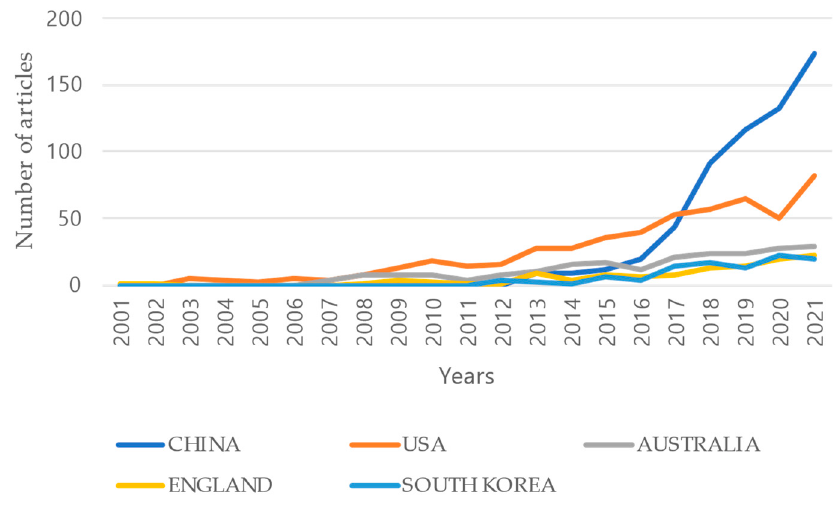
Figure 6. Publishing trends for the top five countries undertaking stormwater runoff management between the years 2001 and 2021.